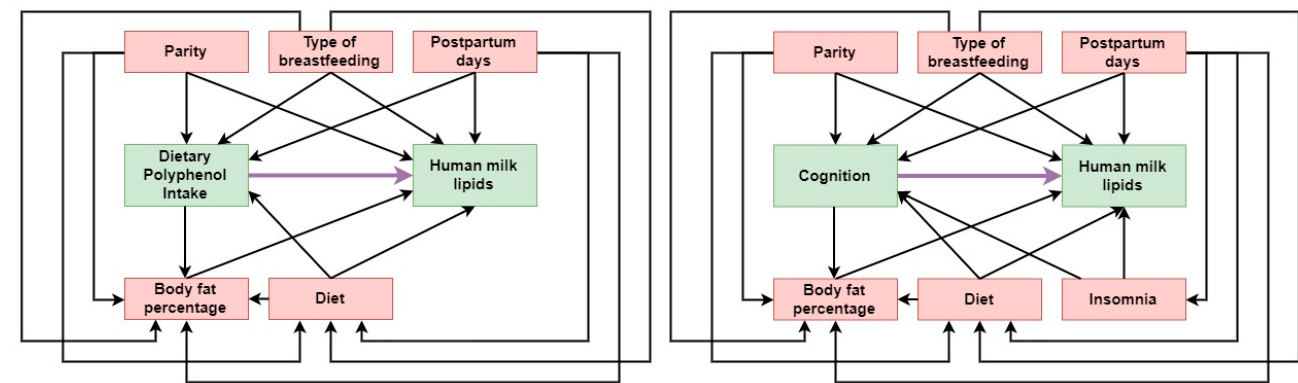
Figure 1. Directed acyclic graph of the relationship among polyphenol intake, cognition, and human milk lipids in postpartum Argentinian women. Green squares indicate the independent (dietary polyphenol intake and cognition) and dependent variables (human milk lipids); red squares indicate minimal sufficient adjustment variables; the bold arrow indicates the relationship between the independent and dependent variables; thin arrows indicate other causal relationships.